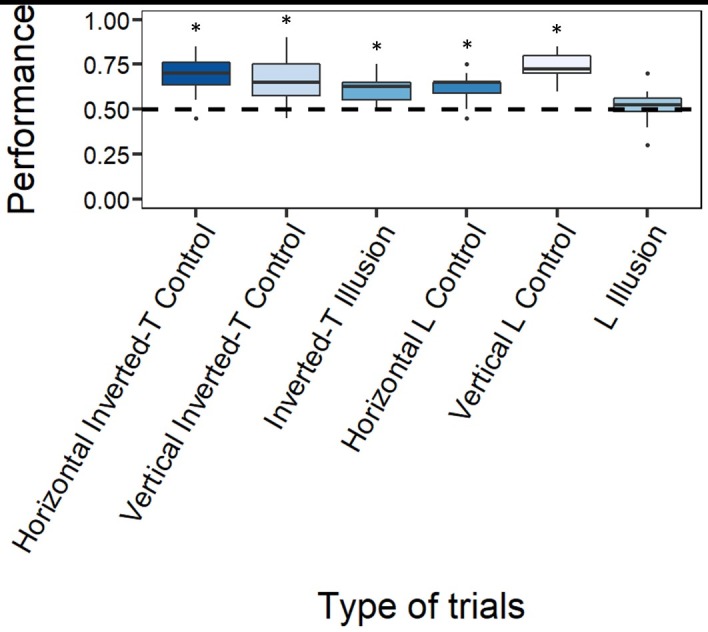
Results.The Y-axis refers to the proportion of choices for the longer target line in the four types of control trials, and the proportion of choices for vertical line in both illusory trials. The asterisk (*) denotes a significant departure from chance level (p < 0.05).